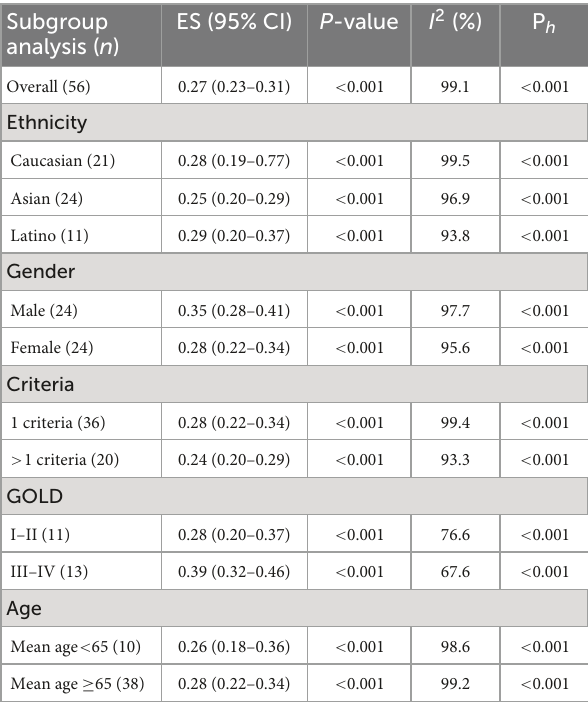
Capacity (FEV1/FVC), predicted FEV1%, and predicted FVC% than those without sarcopenia ( Table 3 ). The result of FEV1/FVC between the COPD group and the COPD + sarcopenia group was